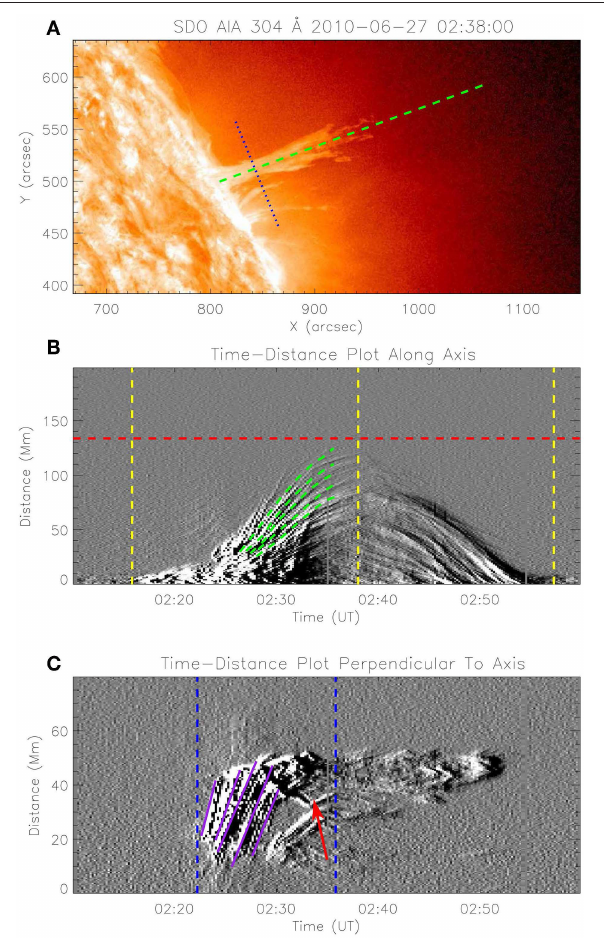
FIGURE 2 | (A) is an off-limb coronal jet observed by SDO/AIA 304 Å passband on 27 th June 2010 at 02:38 UT. Green dashed and blue dotted lines are slits along and perpendicular to the jet axis, respectively. (B) is a running difference time-distance plot along the jet axis. Three yellow vertical dashed lines represent the starting, peak and ending time of the jet, respectively. The red horizontal dashed line denotes the maximum projected length of the jet. Green dashed curves indicate trajectories of sample sub-jets used to estimate the average projected axial speed of the jet during the period of its rotational motion. (C) is a running difference time-distance plot perpendicular to the jet axis. Two blue vertical dashed lines denote the estimated starting and ending time of the rotational motion, respectively. Purple solid lines are linear fittings of the inclined stripes. The red arrow marks a stripe as part of the evidence of the rotational motion. See the text for reasons why these stripes are manifestations of rotational motion, instead of “whip-like” motion.